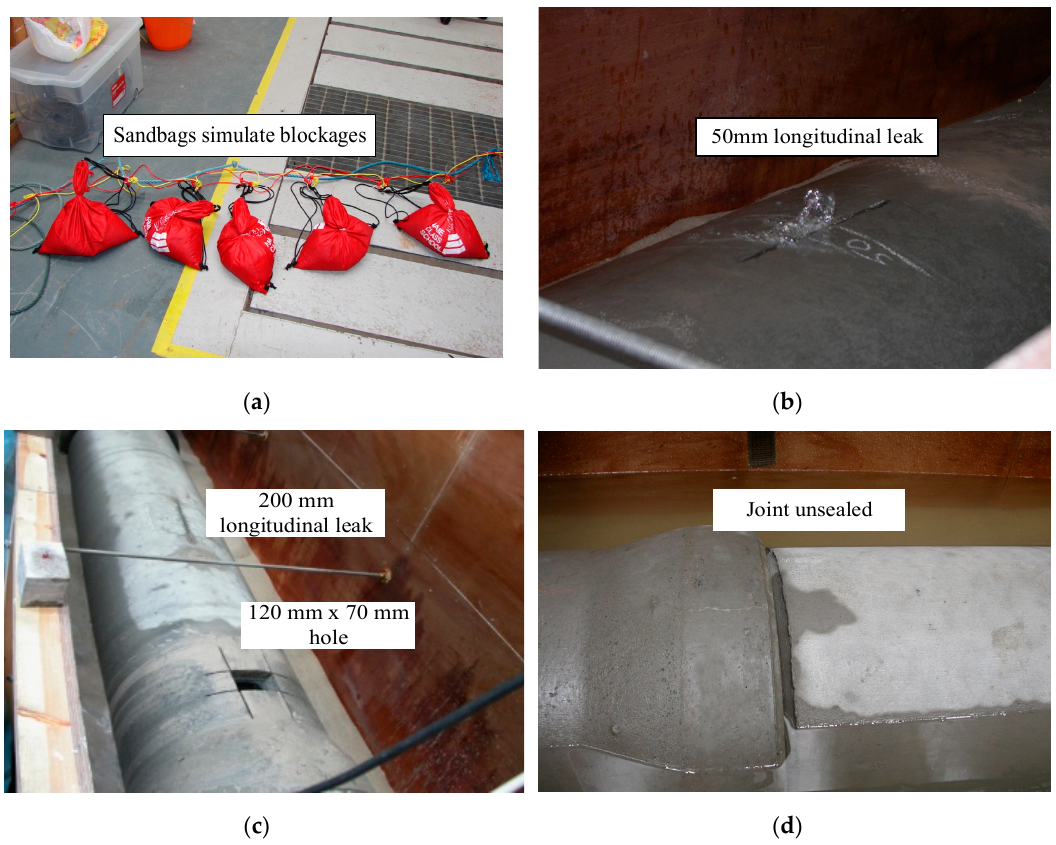
Figure 3. Siphon conditions simulated in the laboratory; ( a ) sandbags, ( b ) 50 mm longitudinal leak, ( c ) 200 mm longitudinal leak and 120 mm × 70 mm hole, ( d ) joint unsealed.